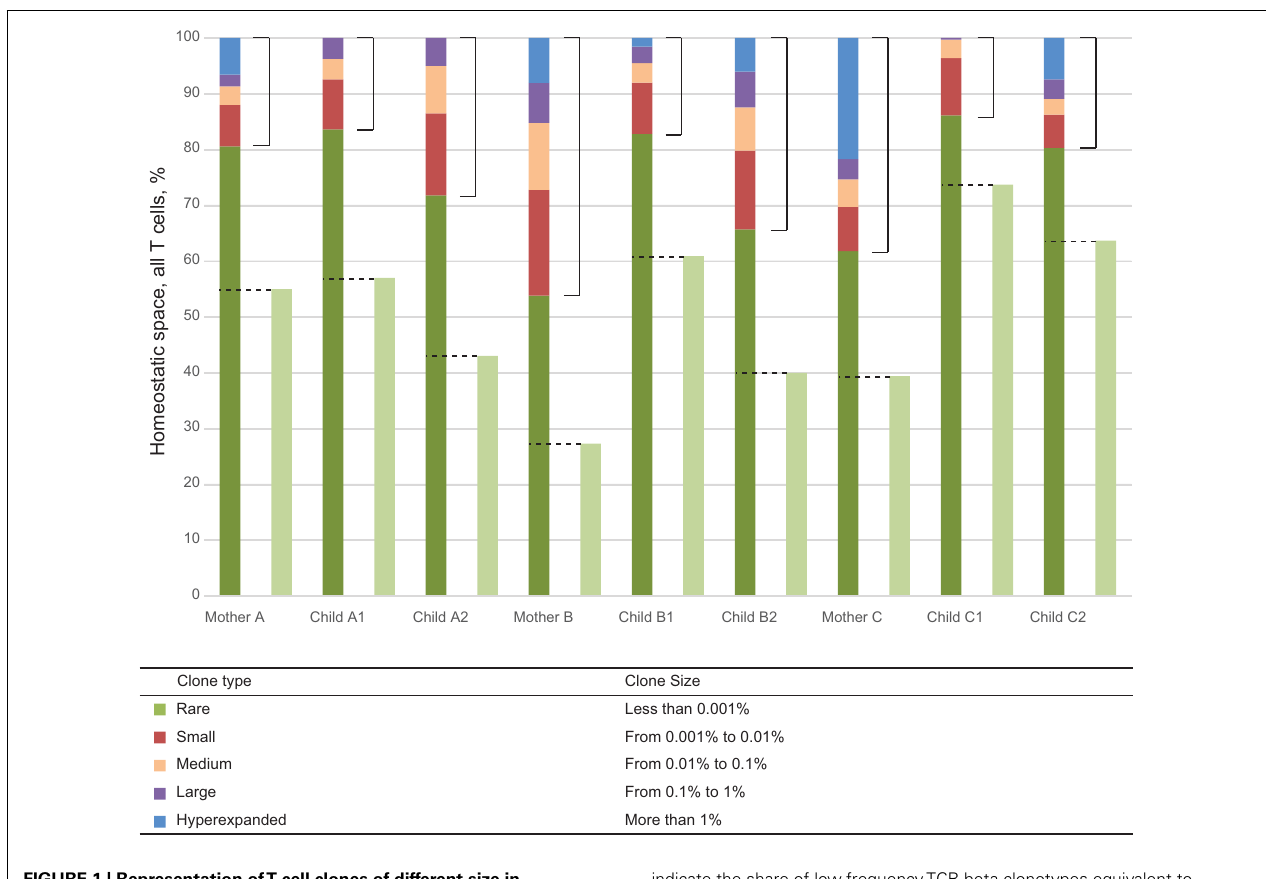
FIGURE 1 | Representation ofT cell clones of different size in individualTCR beta repertoires . Colored bars represent the share of clonal space occupied by clones of given type (classified by size) for each of the nine donors. Light green bars represent the share of naïve CD27 high CD45RA high T cells as determined by FACS analysis. Dashed lines